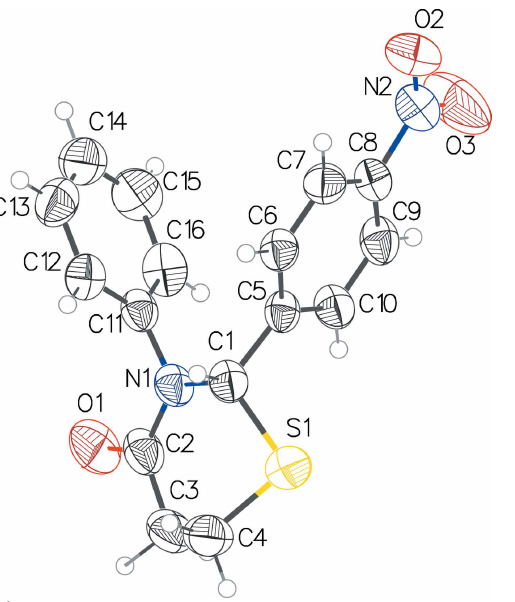
Figure 2 The molecular structure of 2 , with displacement ellipsoids drawn at the 50% probability level.